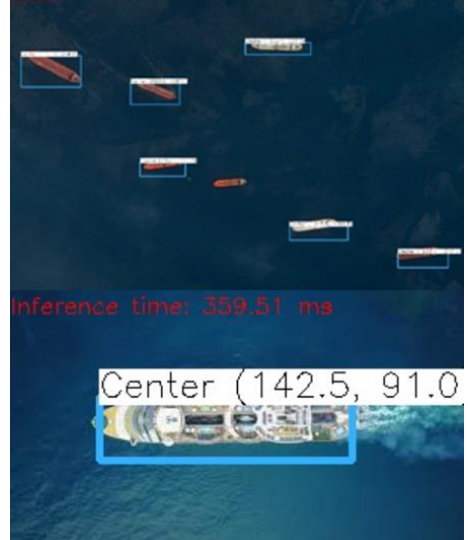
Figure 11. Detected ships by YOLOv3 algorithm